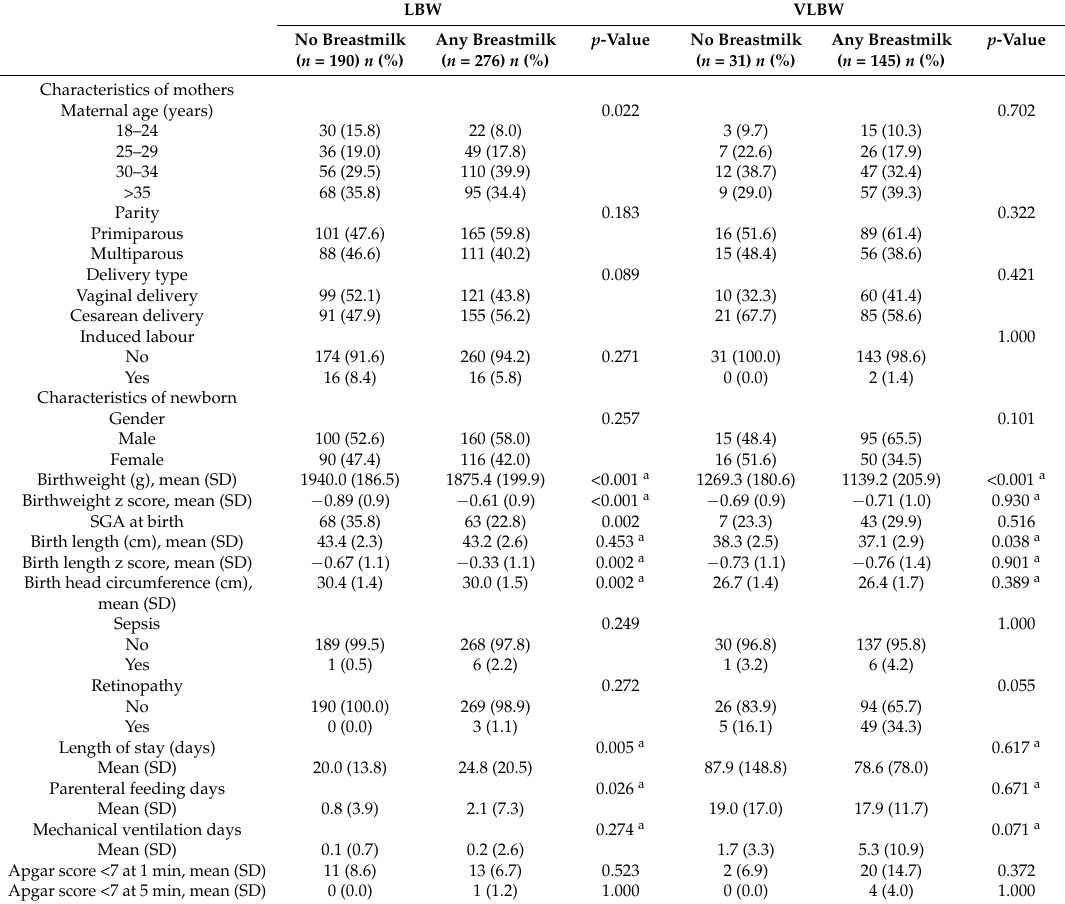
Table 1. Characteristics of LBW and VLBW preterm infants breastfed or not breastfed. LBW VLBW p -Value No Breastmilk p -Value No Breastmilk Any Breastmilk Any Breastmilk ( n = 190) n (%) ( n = 276) n (%) ( n = 31) n (%) ( n = 145) n (%) Characteristics of mothers Maternal age